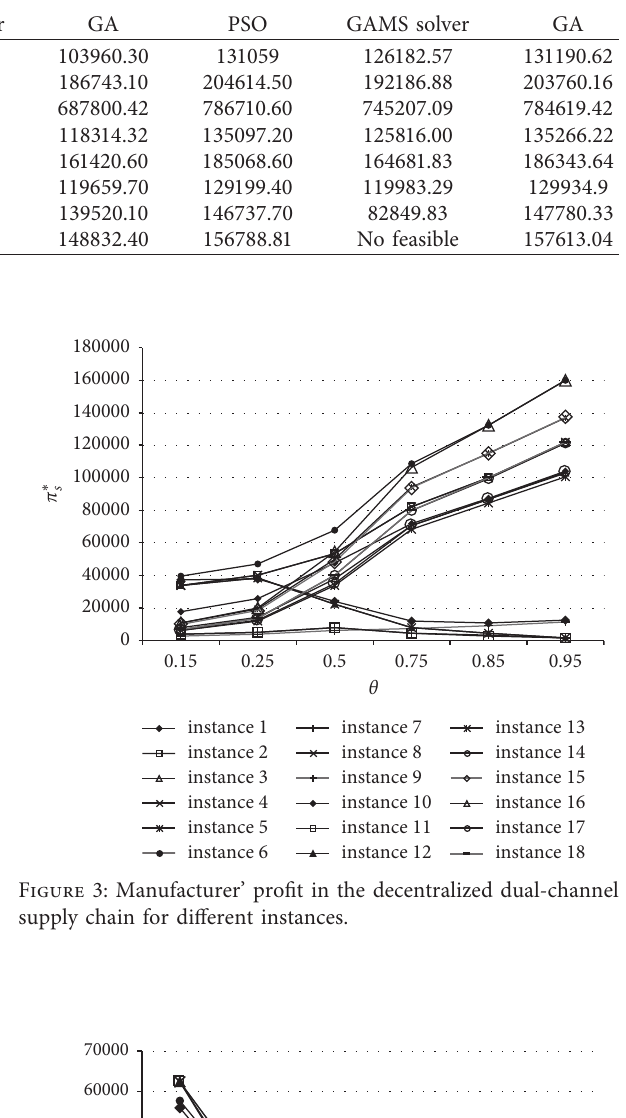
Table 2: A comparison between the GAMS solutions, the presented PSO algorithm, and the GA algorithm. Problem number N